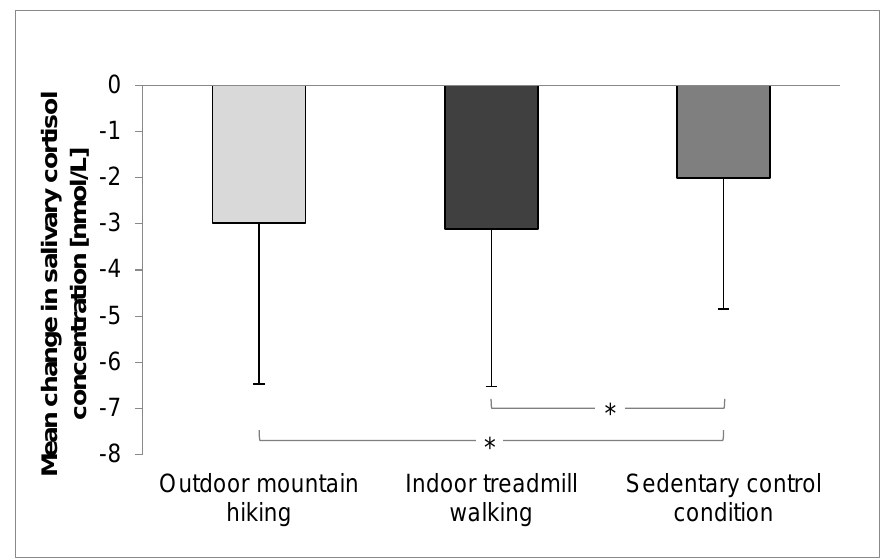
Figure 2. Mean changes in salivary cortisol concentration from baseline to follow-up by condition. * Significant condition by time interaction, error bars represent standard deviations.